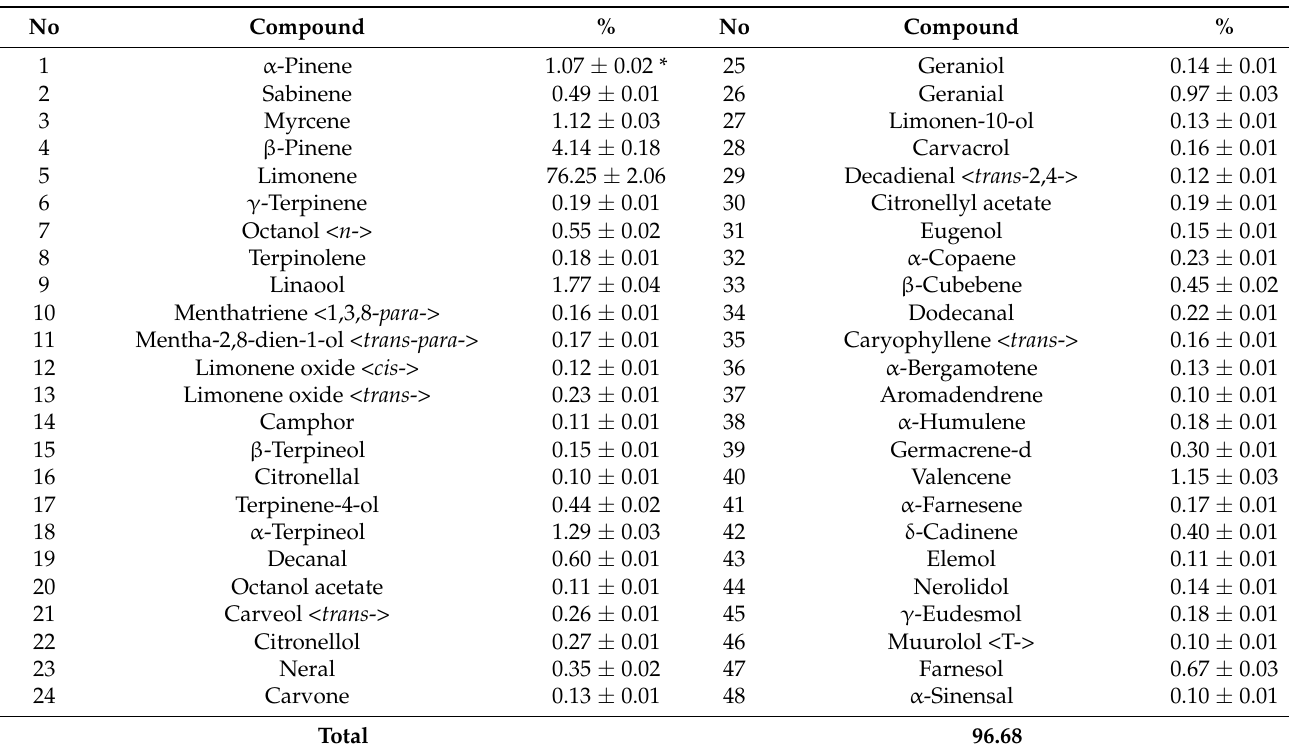
Table 1. Chemical constituents of EO from the pericarp of Citrus cinensis cv New Hall - Citrus aurantium